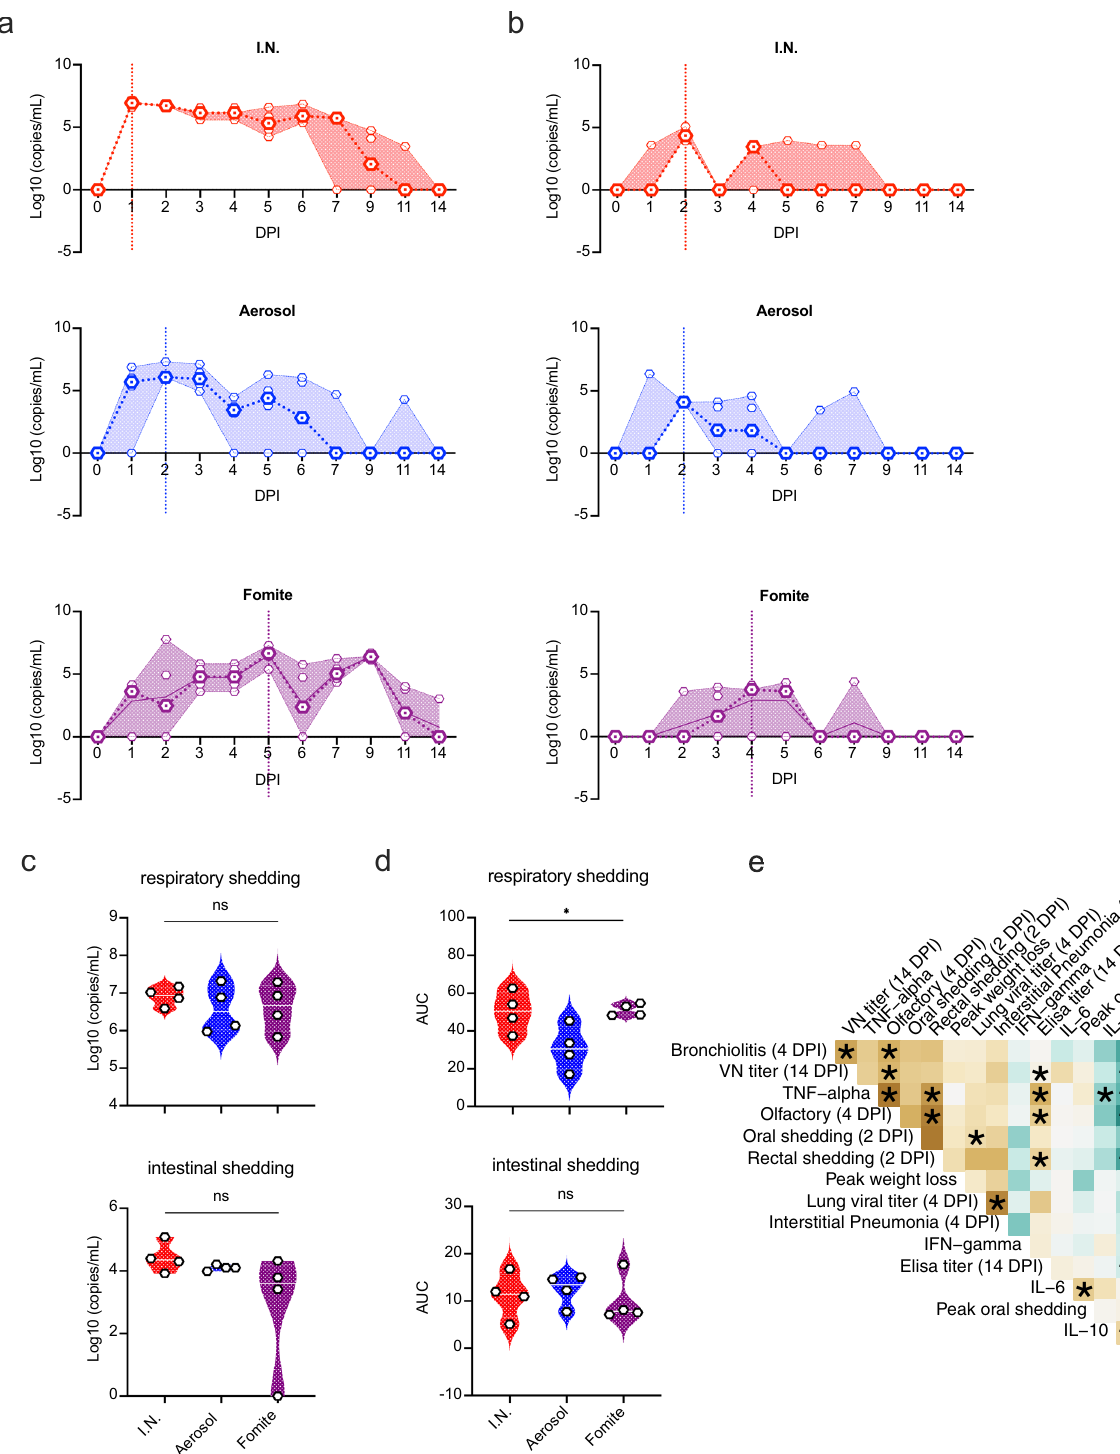
Fig. 5 Exposure dependent SARS-CoV-2 shedding. a Respiratory and b intestinal viral shedding of intranasal (I.N.), aerosol and fomite exposed hamsters. Median, 95% CI and individuals are shown. c Peak shedding and d cumulative (area under the curve (AUC) analysis) respiratory and intestinal shedding of I.N., aerosol and fomite exposed hamsters. Statistical signi fi cance was measured by Kruskal – Wallis test, N = 4 per group. * P < 0.05, ** P < 0.001, *** P < 0.0001, **** P < 0.0001. NS, not signi fi cant. e Correlation between cytokine levels, early shedding (2 days post inoculation (DPI)), peak shedding, peak weight loss, ELISA and virus neutralization (VN) titers (14 DPI), lung titers and pathology at 4 DPI. Signi fi cant correlations ( N = 4 per group, Pearson – Spearman analysis, p < 0.05) are indicated with an asterisk and strength of correlation ( R 2 ) is depicted according to the color bar on the right. Source data are provided as a Source Data fi